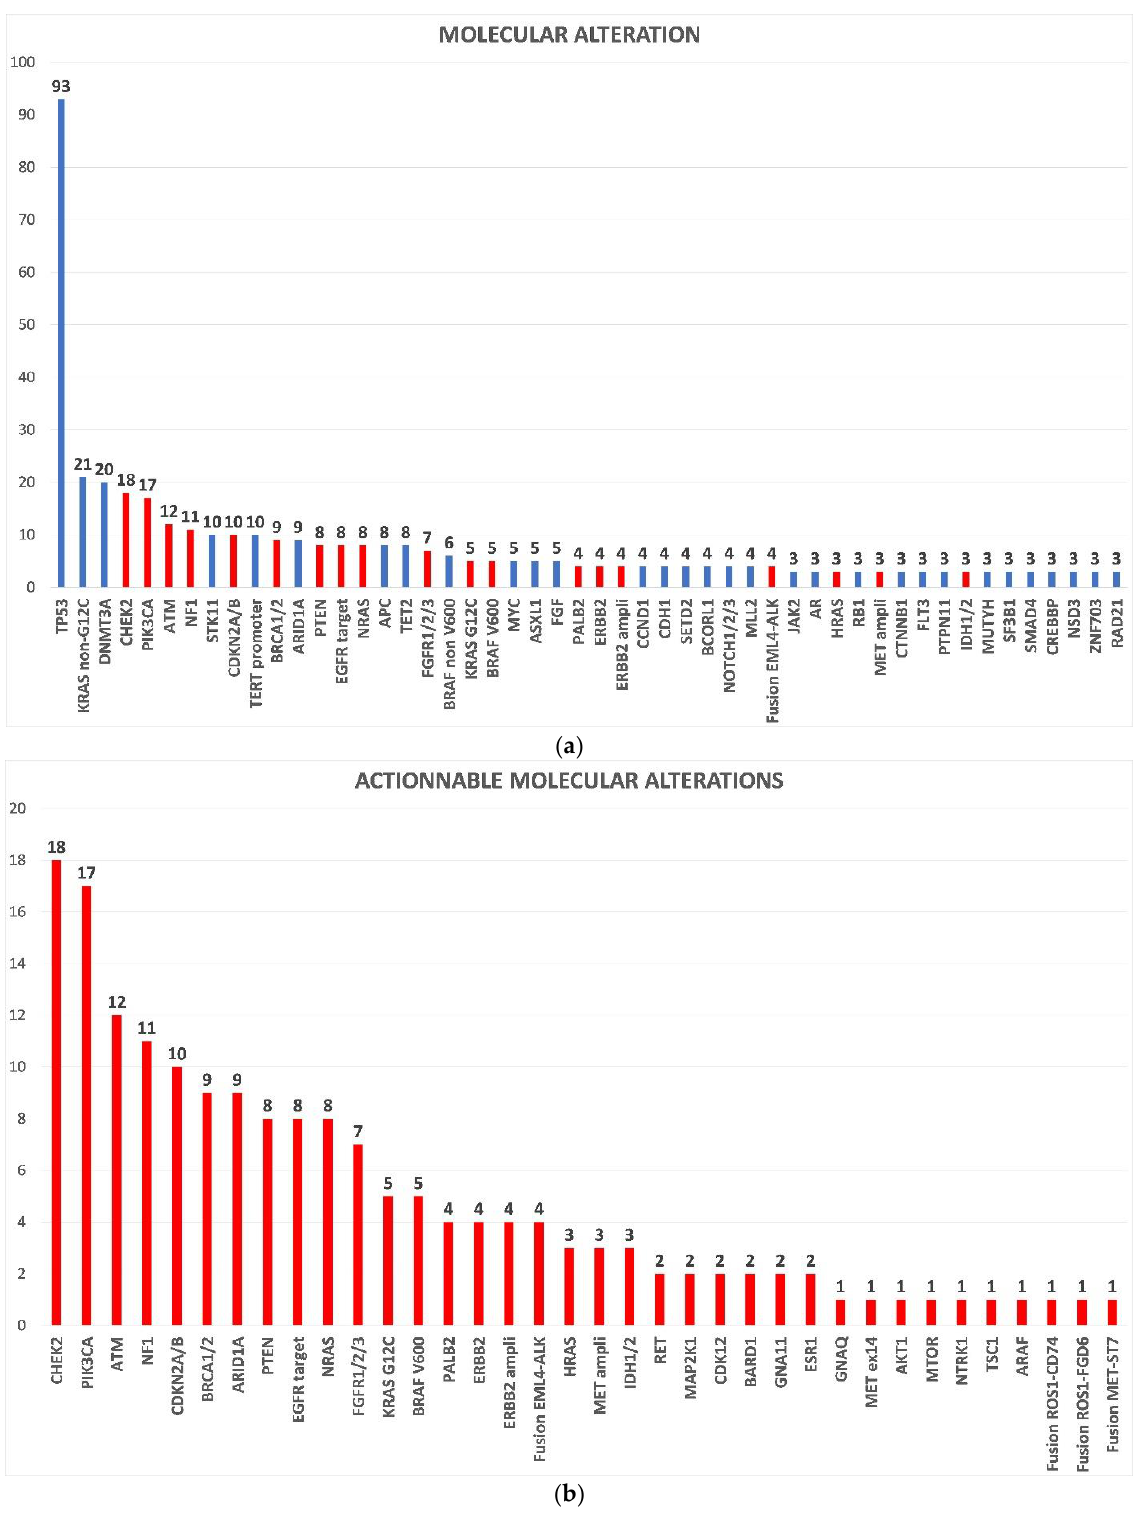
Figure 2. ( a ) 50 most frequent molecular alterations in the overall population and ( b ) actionable molecular alterations in the overall population. Actionable molecular alterations are colored in red. Non-actionable molecular alterations are colored in blue. Number of patients are provided above